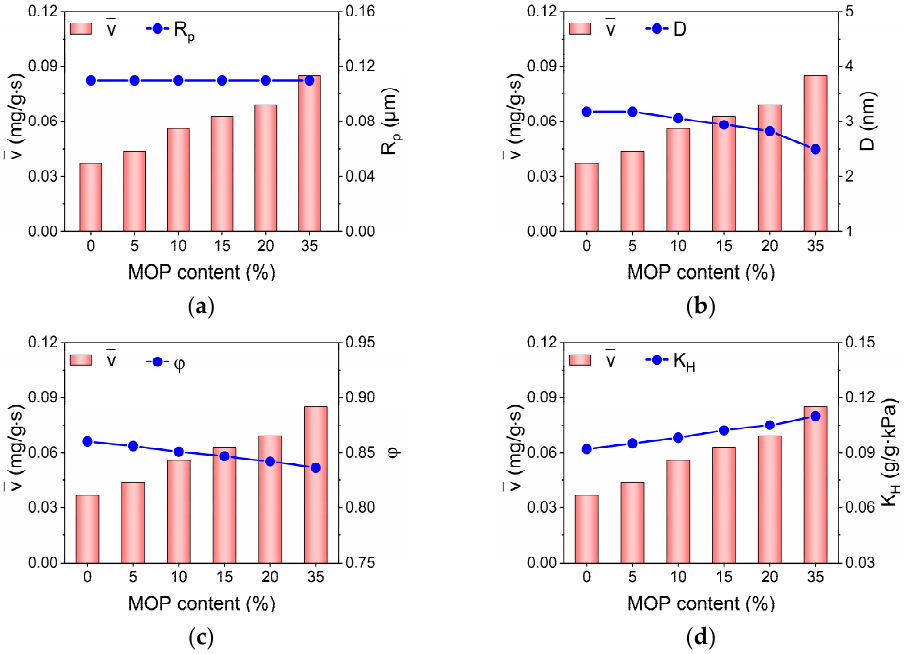
Figure 5. Relationship between ( a ) particle size (R p ), ( b ) pore size (D), ( c ) porosity ( φ ), ( d ) Henry’s constant (K H ), and water adsorption rate ( v ) of MOP/MIL-101(Cr) composites with different MOP 3 content.